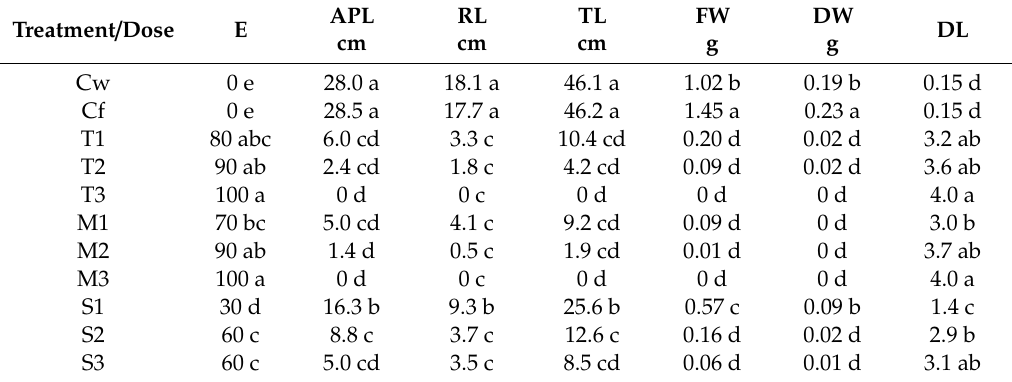
Table 4. E ff ects of T. capitata (T1, T2 and T3 are 4, 8 and 12 µ L mL − 1 dose of essential oil), M. piperita (M1, M2 and M3 are 12, 16 and 20 µ L mL − 1 dose of application), and S. chamaecyparissus (S1, S2 and S3 are 12, 16 and 20 µ L mL − 1 dose of application) essential oils applied by irrigation against A. fatua on the e ffi cacy (E), plant biometric variables [aerial part (APL), root (RL) and total length (TL), fresh (FW) and dry weights (DW)] and damage level (DL). Cw (only water, neither Fitoil nor EO application), Cf (0.03 µ L Fitoil g − 1 of soil, no EO application). The damage level (DL) was assessed developing a damage scale ranging from 0 (no damage) to 4 (death of the plant). The e ffi cacy (E) of a given EO was considered as its capacity to kill the plants and was assessed by attributing the value 0 if the plant was alive and 100 if the plant was dead. Both DL and E are dimensionless. Data are the arithmetic mean of 10 replicates.